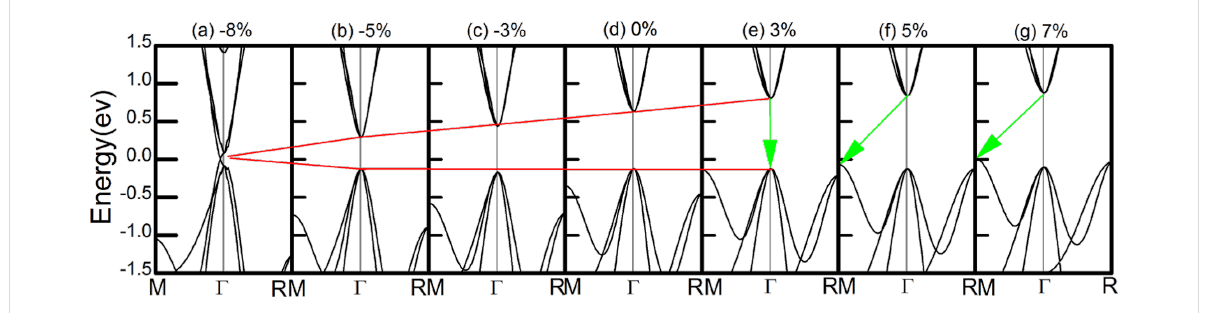
Figure 2: The modulation of band gap (red line) by hydrostatic and tensile strain ( − 8% to +7%) in ThTaN 3 by using the HSE method. A Dirac cone emerges when a − 8% strain is added to the ThTaN 3 compound. And the green arrow shows that the change from a direct band gap to an indirect band gap with strain is increased from 3% to 7%. The Fermi level is set at an energy of